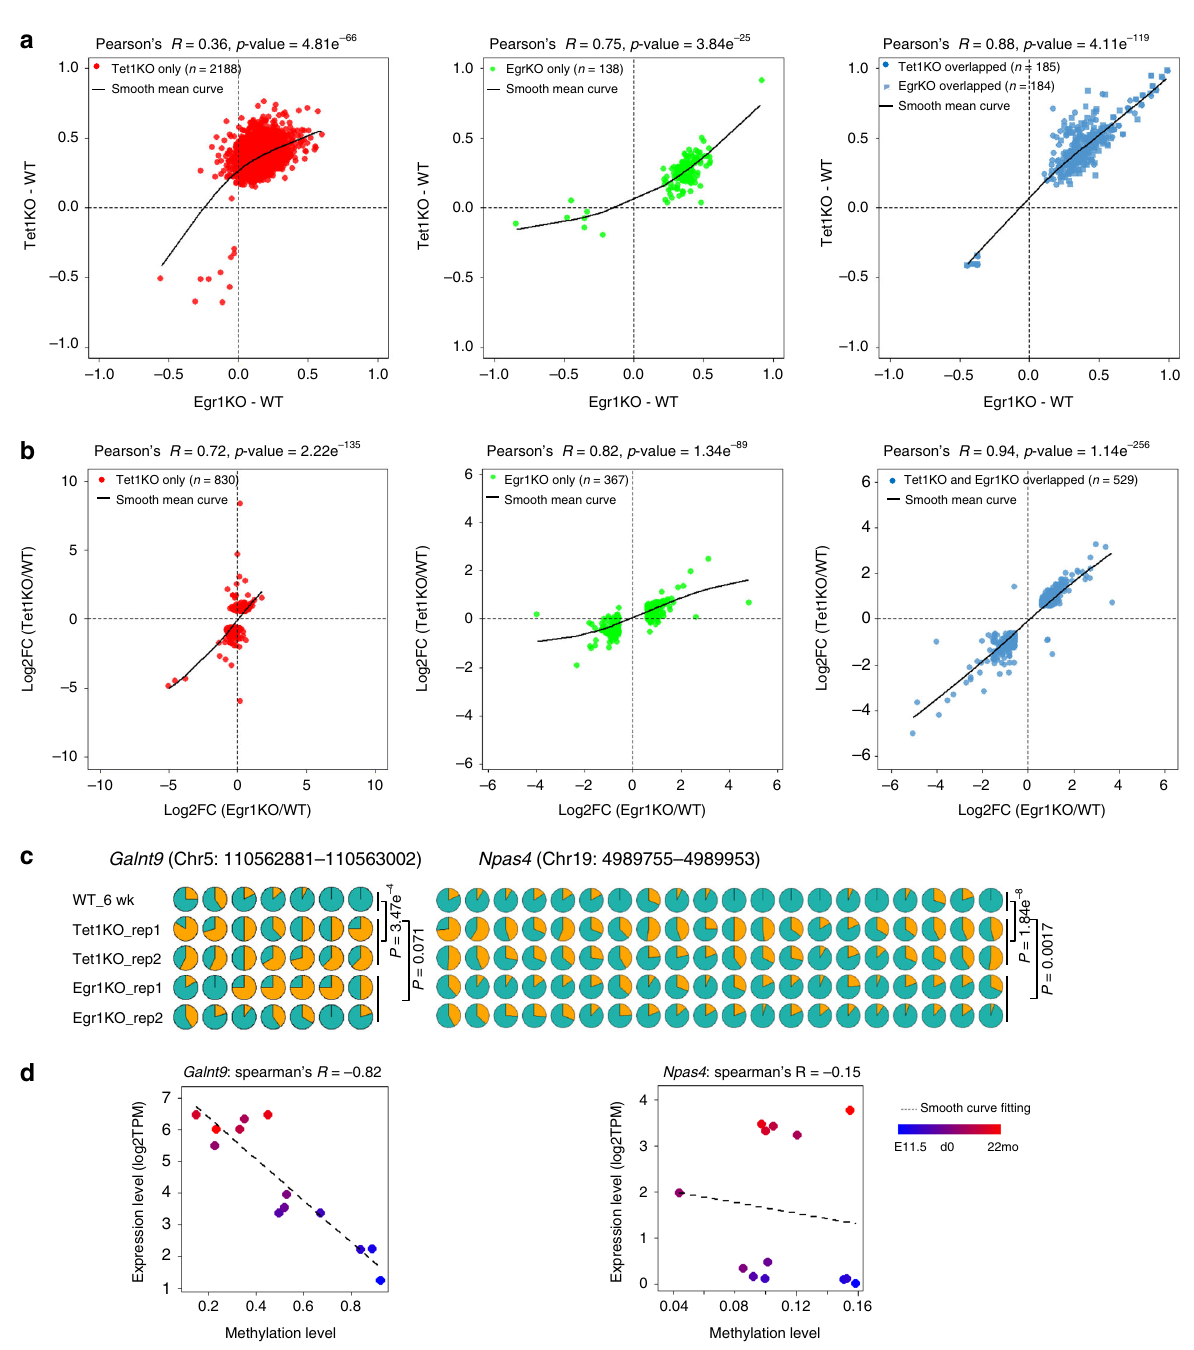
Fig. 5 Correlations of DNA methylation and gene expression pro fi les between Egr1KO and Tet1KO frontal cortices. Methylation correlations ( a ) and gene expression correlations ( b ) between Egr1KO and Tet1KO mice. c Aberrant DNA methylation on Galnt9 and Npas4 loci. Each CpG is represented by a circle; yellow in circles indicates the percentage of methylation in each CpG site. The statistical signi fi cance of methylation differences between Egr1/Tet1KO and WT mice was evaluated with the Wilcoxon rank-sum test. d The correlations between DNA methylation levels of Galnt9, Npas4 loci and corresponding gene expression during brain development from embryonic day 11.5 (E11.5) (denoted in blue color) to 22 months (22 mo) (denoted in red color)